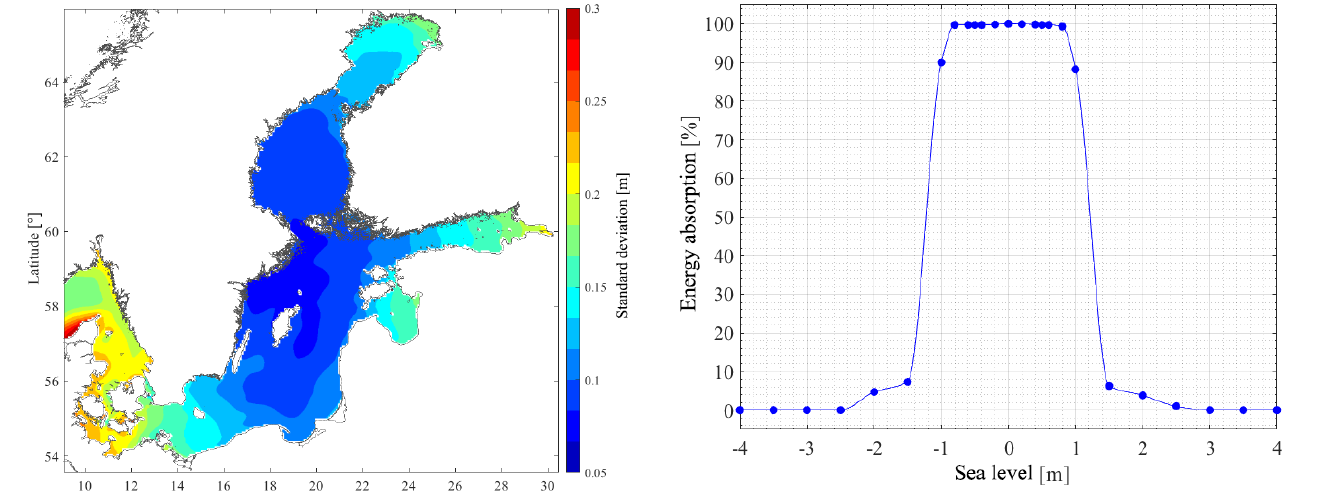
Figure 7. SD 10y – decadal SD of the SSH 1h over the 10-year win- dow. The colour scale is different from the one in Fig. 6 for ease of readability and visualization.